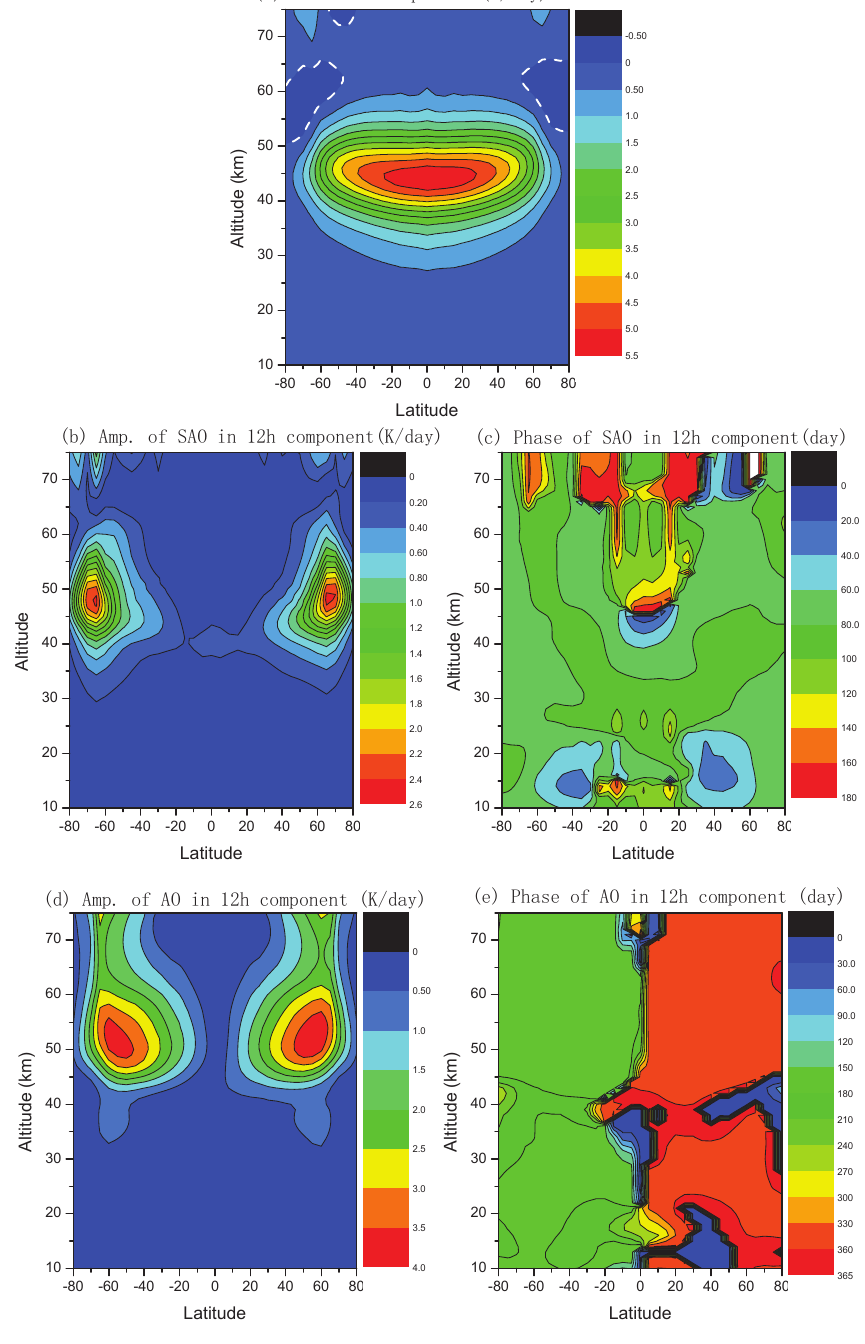
Fig. 9. The annual mean semidiurnal component in ozone heating rate over the period from August 2004 to November 2010 (a) ; the amplitudes (b) , (d) and the phases (c) , (e) of the SAO and AO variations in the semidiurnal component in ozone heating rate. The phase labels give the day of maximum heating. The white dashed line shows the boundary between positive and negative.